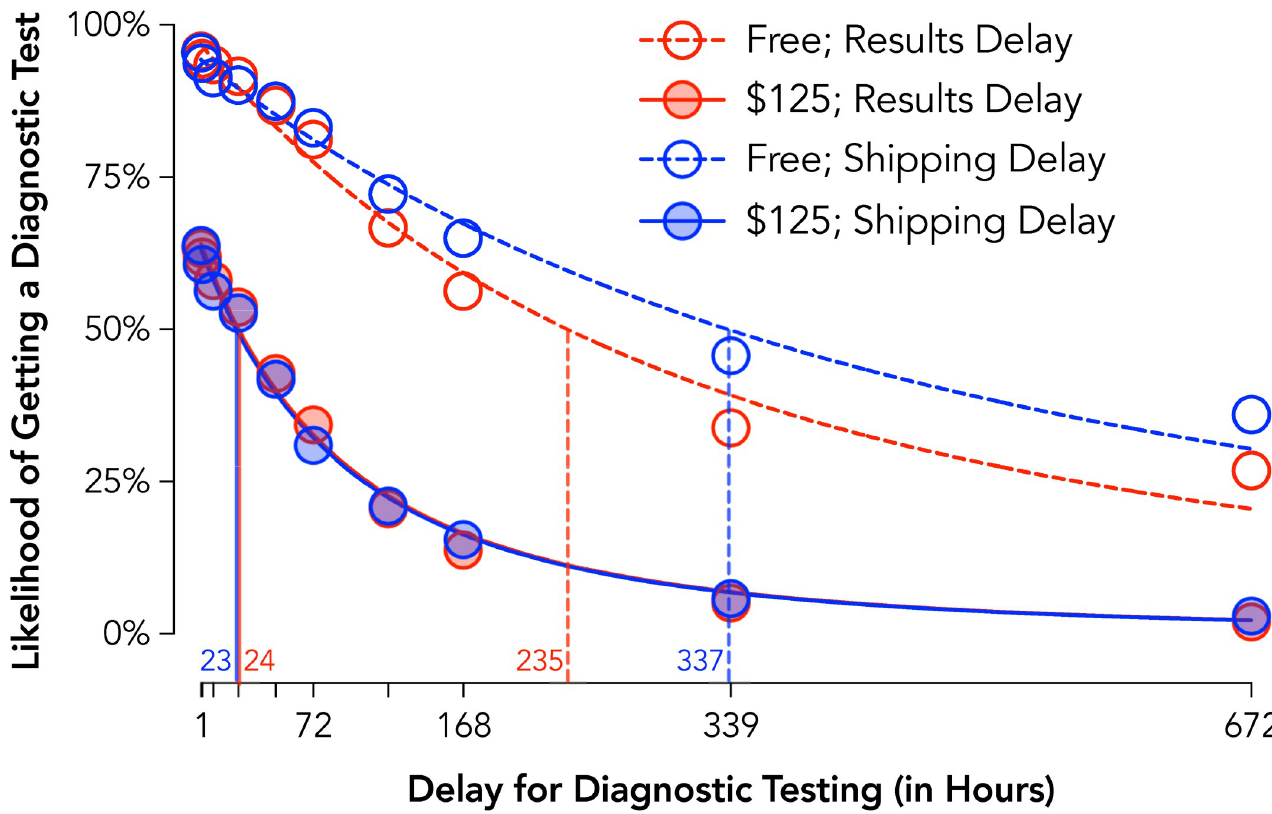
Fig 5. Delay discounting of COVID-19 diagnostic testing by delay type and cost (Experiment 5). Plotted are group discounting curves by delay type (delay to receiving a test with immediate feedback = red circles; delay to receiving results from an immediate test = blue circles) and cost (Free = open circles, dotted lines; $125; closed circles, solid lines). Curves are plotted using the hyperbolic discounting equation including a non-linear scaling parameter [43]. Vertical lines are estimated ED50 or the delay at which half of the population is likely to procure a test.